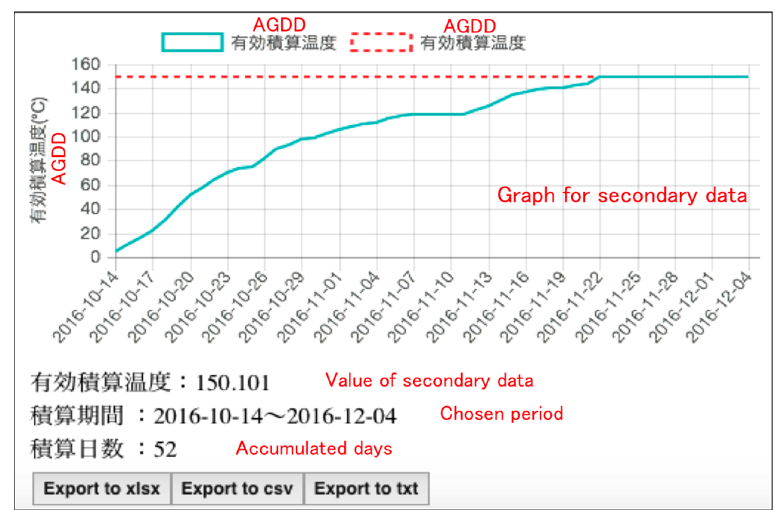
Figure 15. Polygonal line graph shown in this web application.